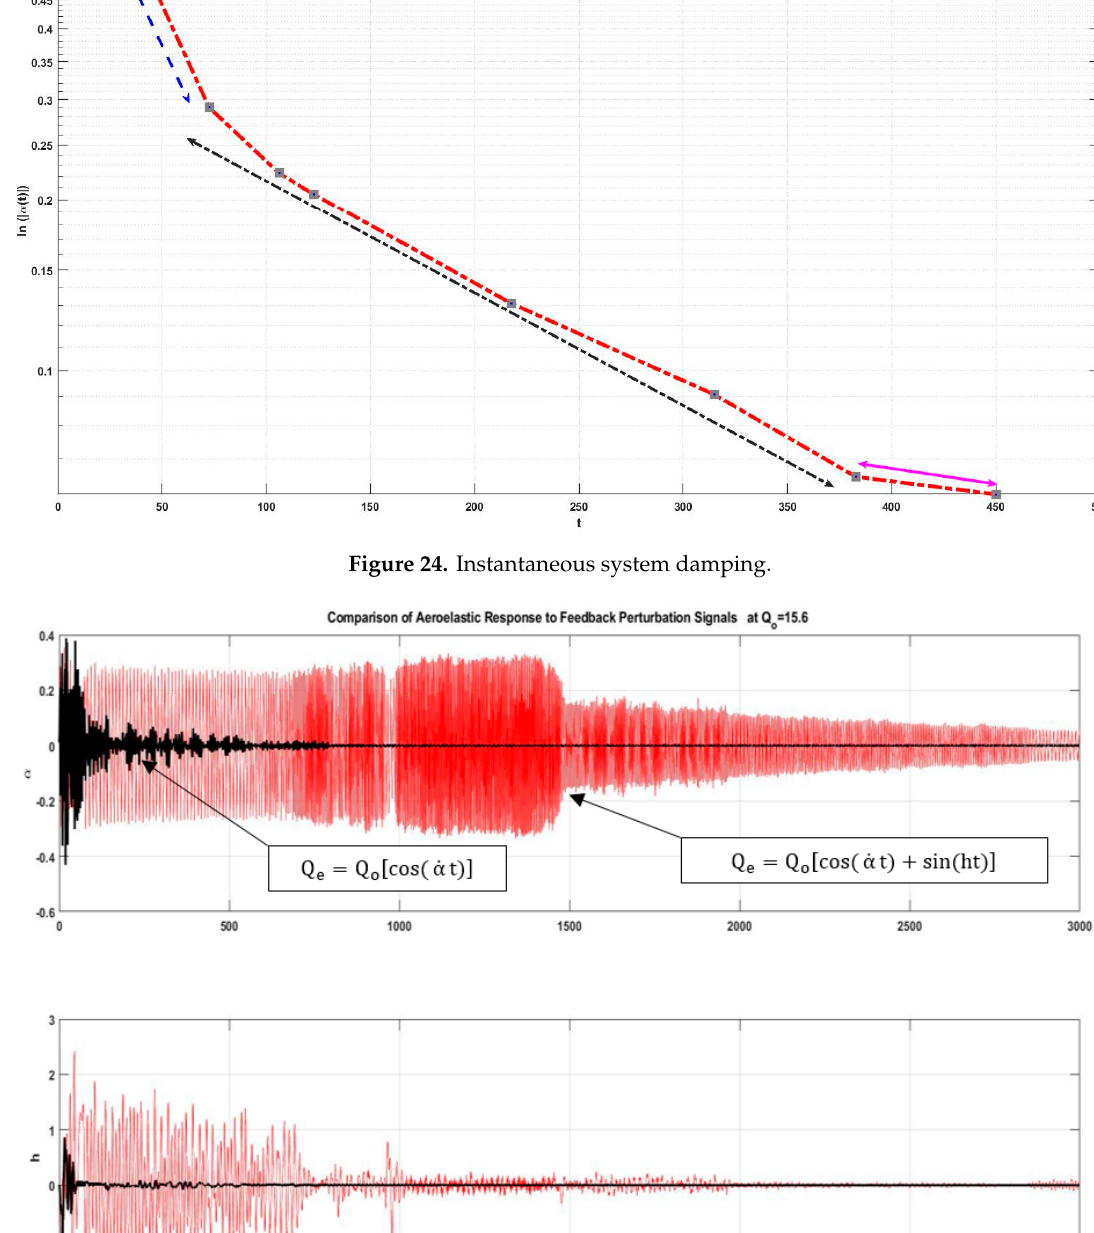
Figure 25. Effect of perturbation signals of aeroelastic response. Figure 25. E ff ect of perturbation signals of aeroelastic